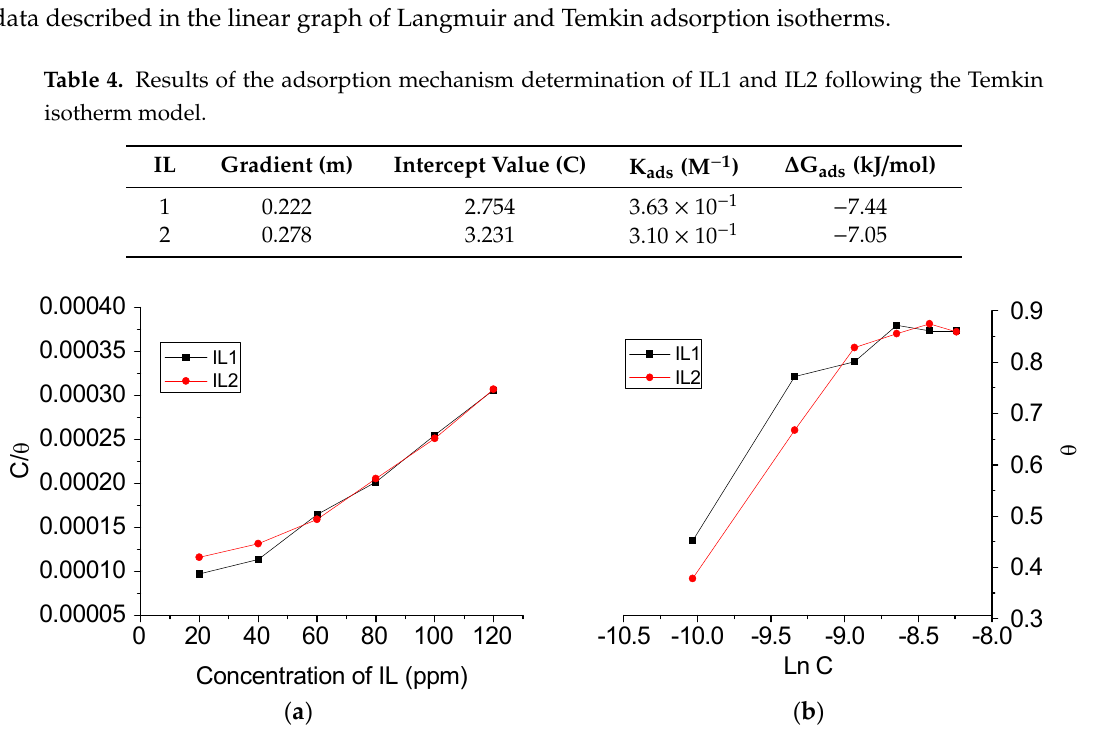
Figure 4. Langmuir adsorption isotherm ( a ) and Temkin adsorption isotherm ( b ) for IL1 and IL2.